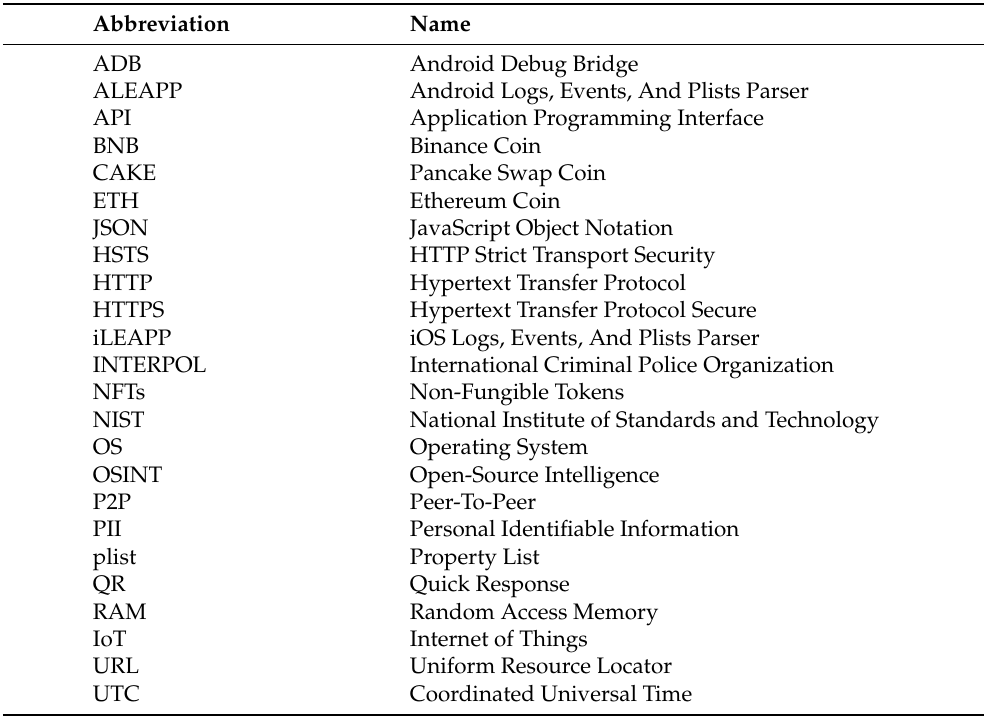
Table 1. Abbreviations used in the